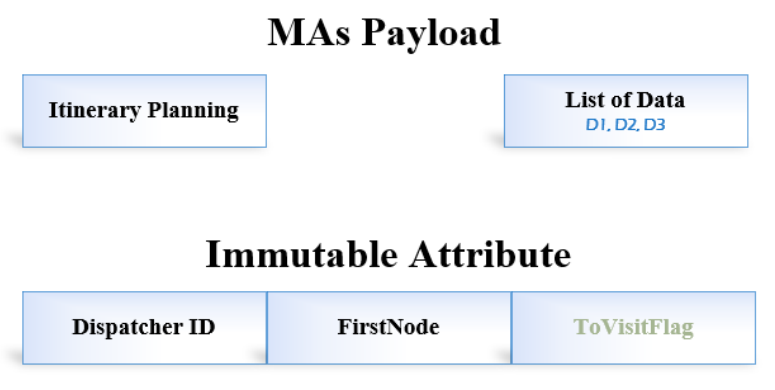
Figure 2. Proposed itinerary message format.